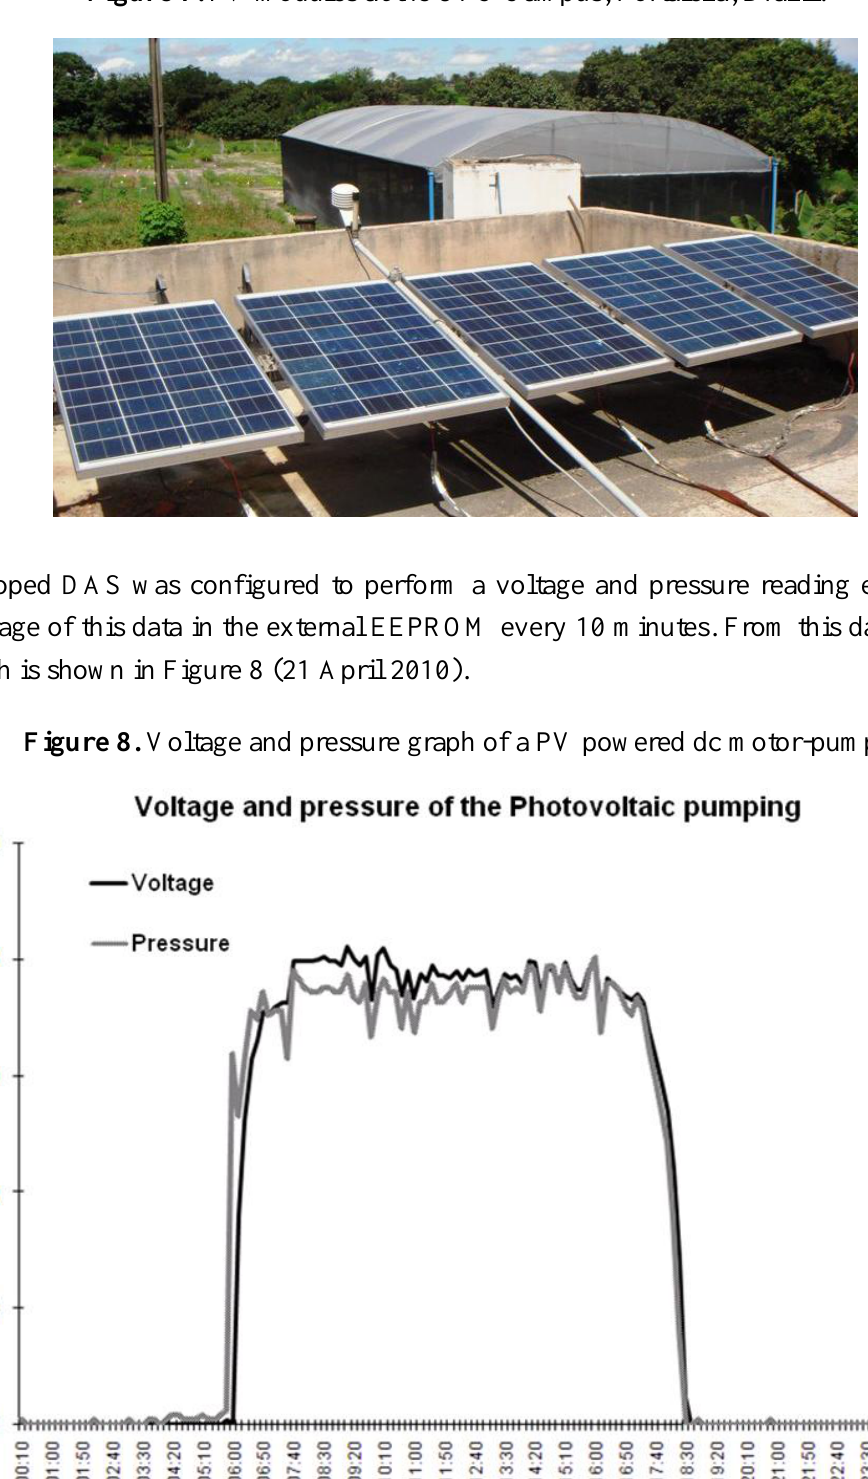
Figure 7. PV modules at the UFC Campus, Fortaleza, Brazil.